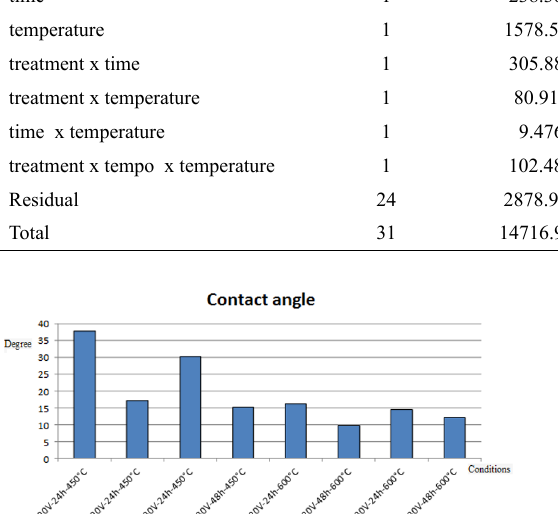
treatment x temperature